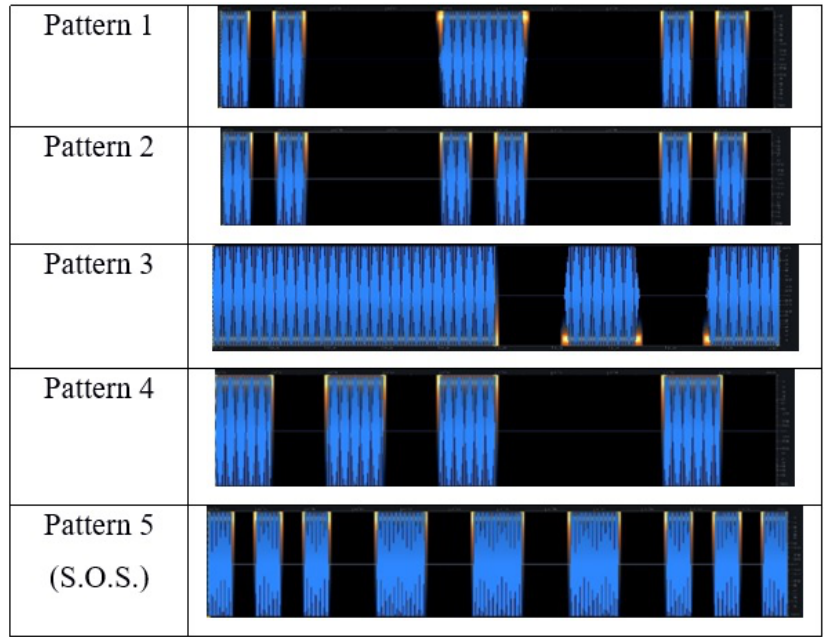
Figure 2. Patterns P1 to P5 used in the experiment for sessions